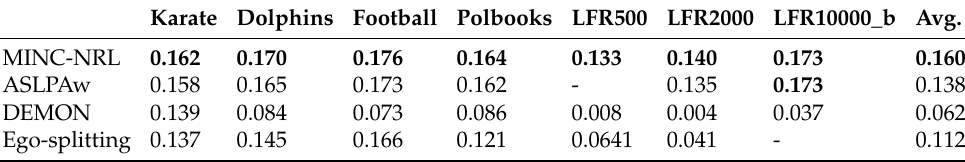
Table 8. EQ of MINC-NRL compared with other algorithms.